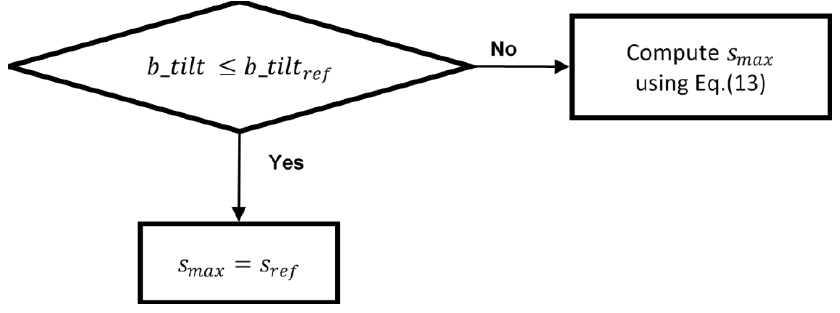
Figure 15. Procedure to compute 𝑠 𝑚𝑎𝑥